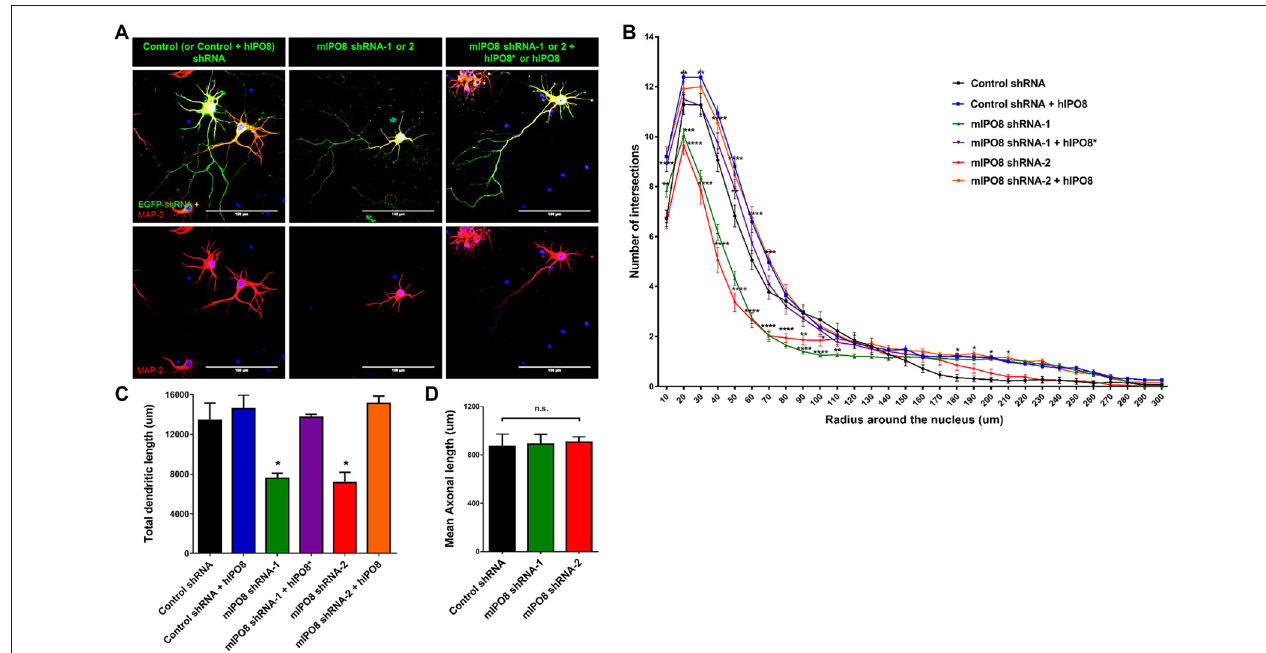
FIGURE 6 | In vitro dendritogenesis of cortical neurons is impacted by Ipo8 knockdown. (A) Immunolabeling for EGFP and Map2 of representative cortical neurons. IUE was performed at E13.5 with either shRNA producing plasmid alone for knockdown studies or with both the shRNA and hIPO8 producing plasmids for rescue experiments (see Figure 2 ). Two days later, cortices were dissociated and neurons were cultured for 7 days in vitro (DIV). (B) Sholl analysis of the dendritic complexity. (C) Total dendrite length of neurons. (D) Axonal length of neurons. The control shRNA condition was taken as reference for statistical analysis ∗ p <